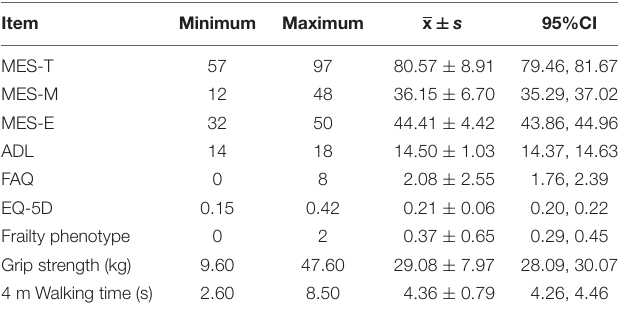
TABLE 2 | Scores of cognitive function, frailty, and health outcome ( n = 252). Item